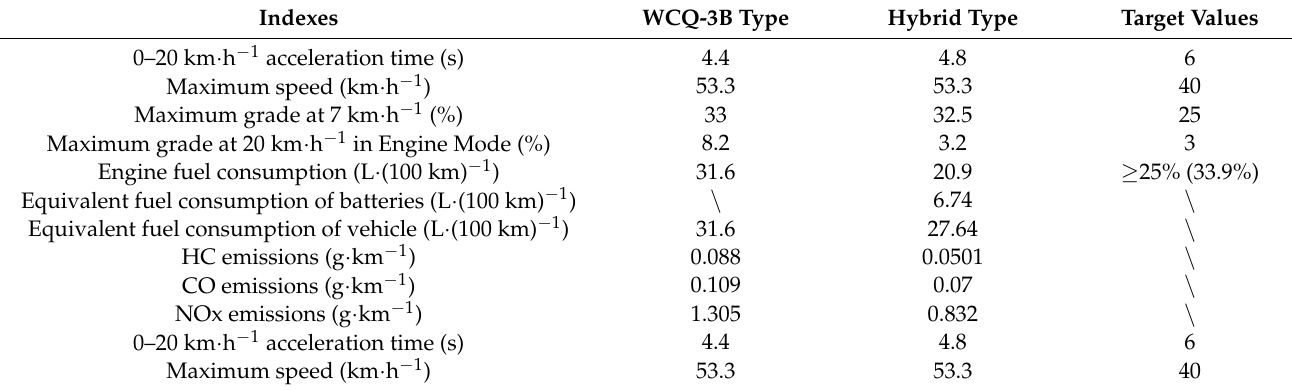
Table 9. Simulation results of two kinds of trackless rubber-tyred